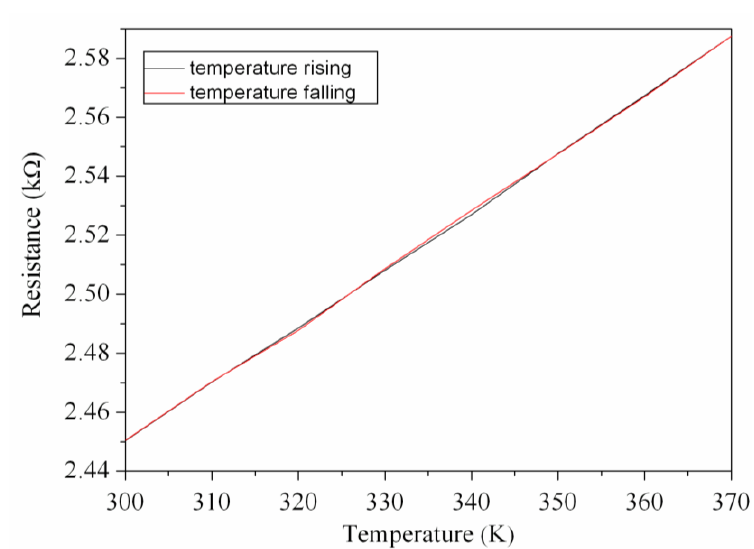
Figure 9. Resistance of the generator.